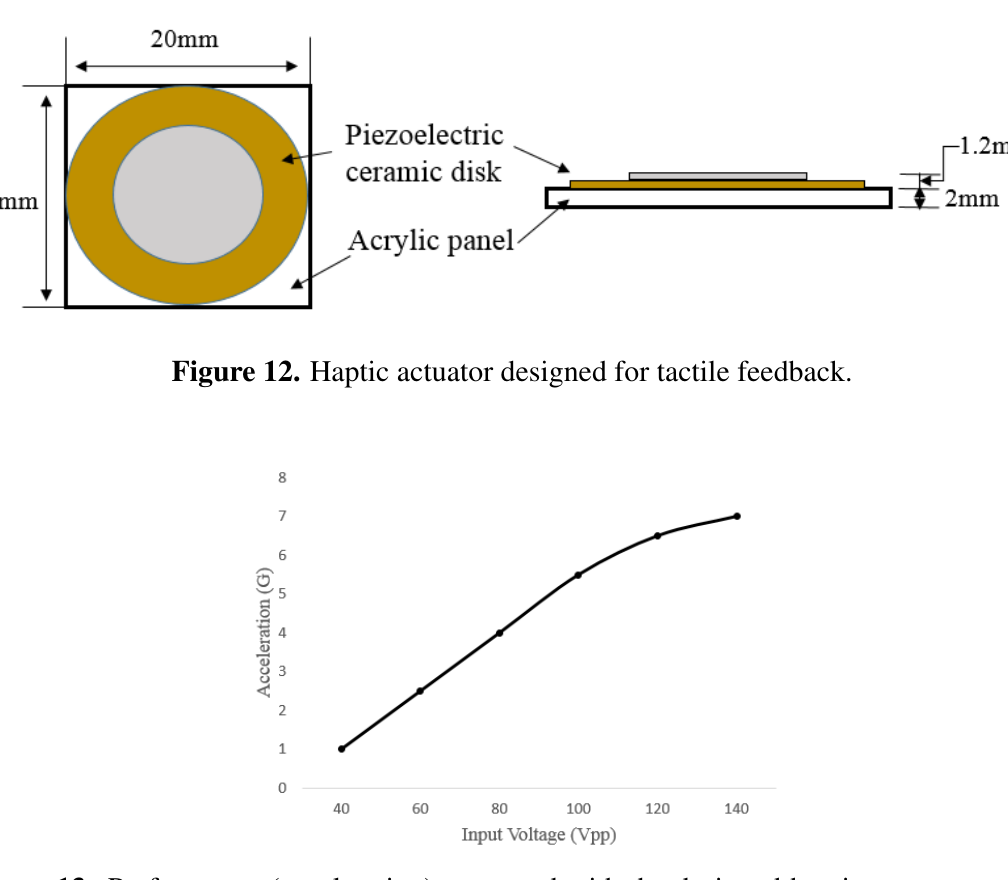
Figure 13. Performance (acceleration) measured with the designed haptic actuator vs. the input